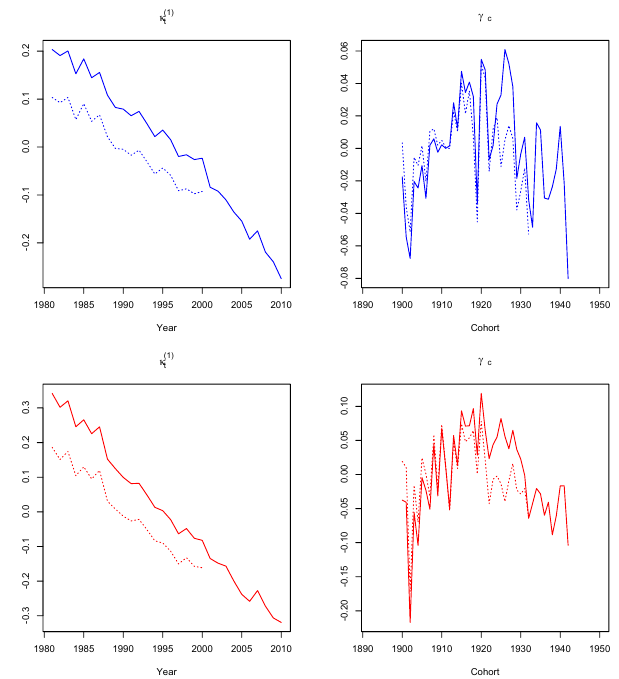
( 1 ) Figure 3. M 3 : κ and γ c estimated parameters for males ( top panels) and females ( bottom panels), t aged 60–89, fitted in 1981–2010 (solid lines) and 1981–2000 (dotted lines).